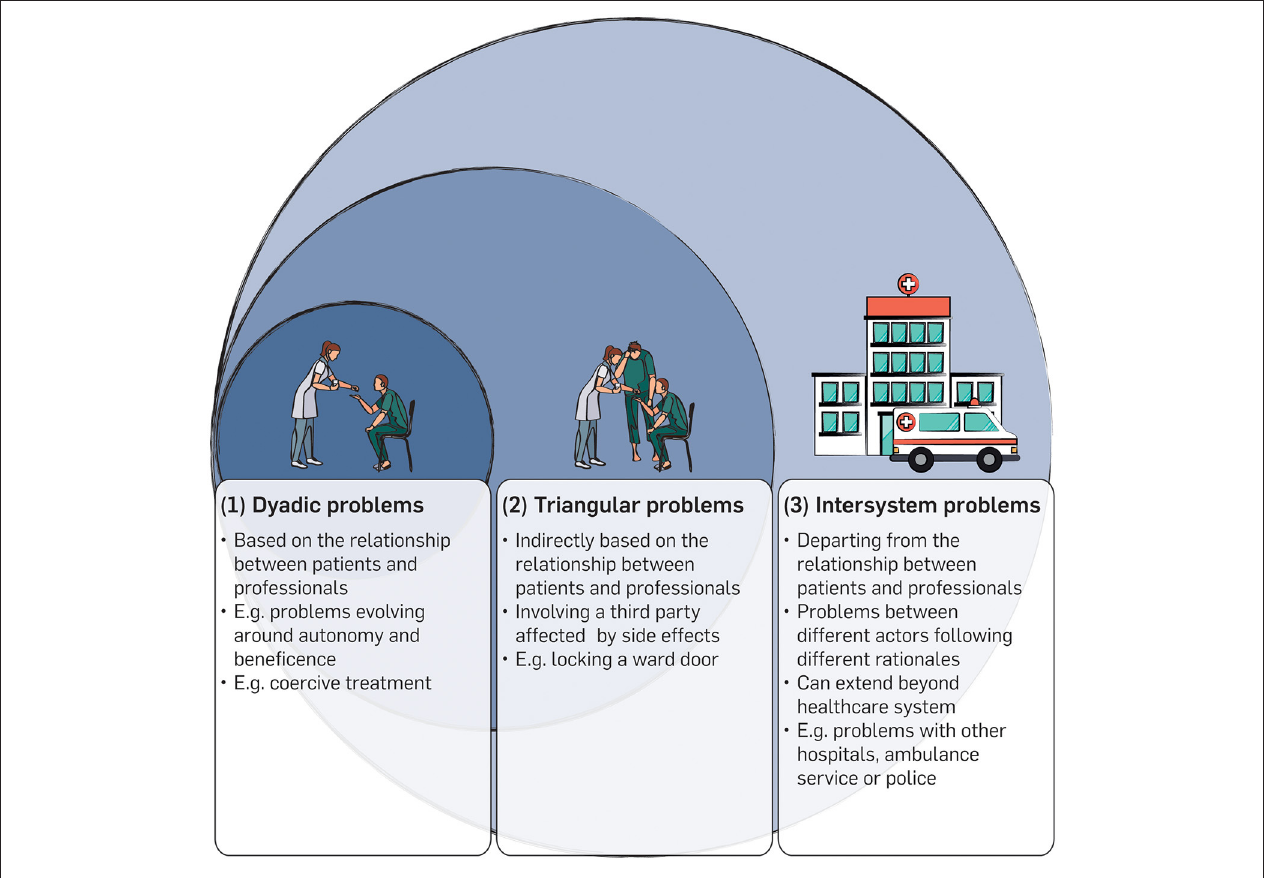
FIGURE 1 | Typology of ethical